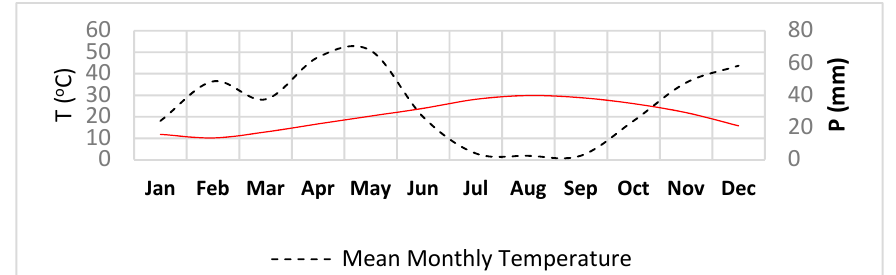
Figure 4. Ombrothermic diagram based on the meteorological data (1996–2016) at the synoptic station of Arak.